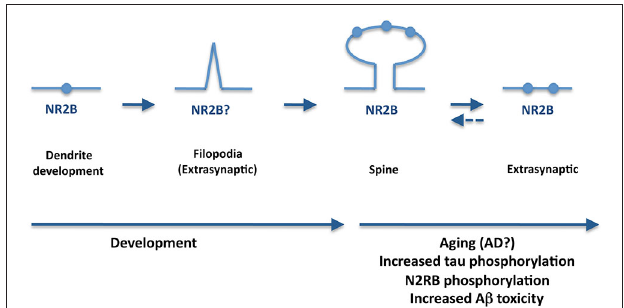
FIGURE 2 | A potential role for tau in synapsis during aging and AD . During AD, tau is hyperphosphorylated and mislocates to the axonal compartment. Furthermore, tau appears essential for A β -induced synaptotoxicity whereas extrasynaptic NR2B-containing NMDA receptors are required for tau-induced neurodegeneration. An increase of extrasynaptic receptors with aging and AD may also explain the progression of the